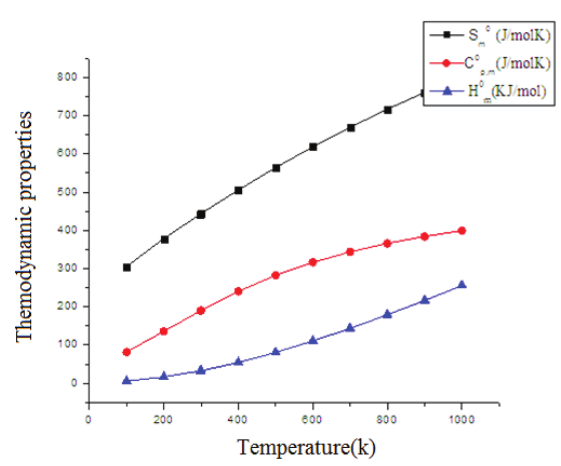
Figure 8: Correlation graphs of thermodynamic properties at different temperature of N -acetylisatin. Table 7 : Experimental and computed NMR ( 13 C and 1 H) chemical shifts of t N -acetylisatin using B3LYP/6-311++G(d,p).